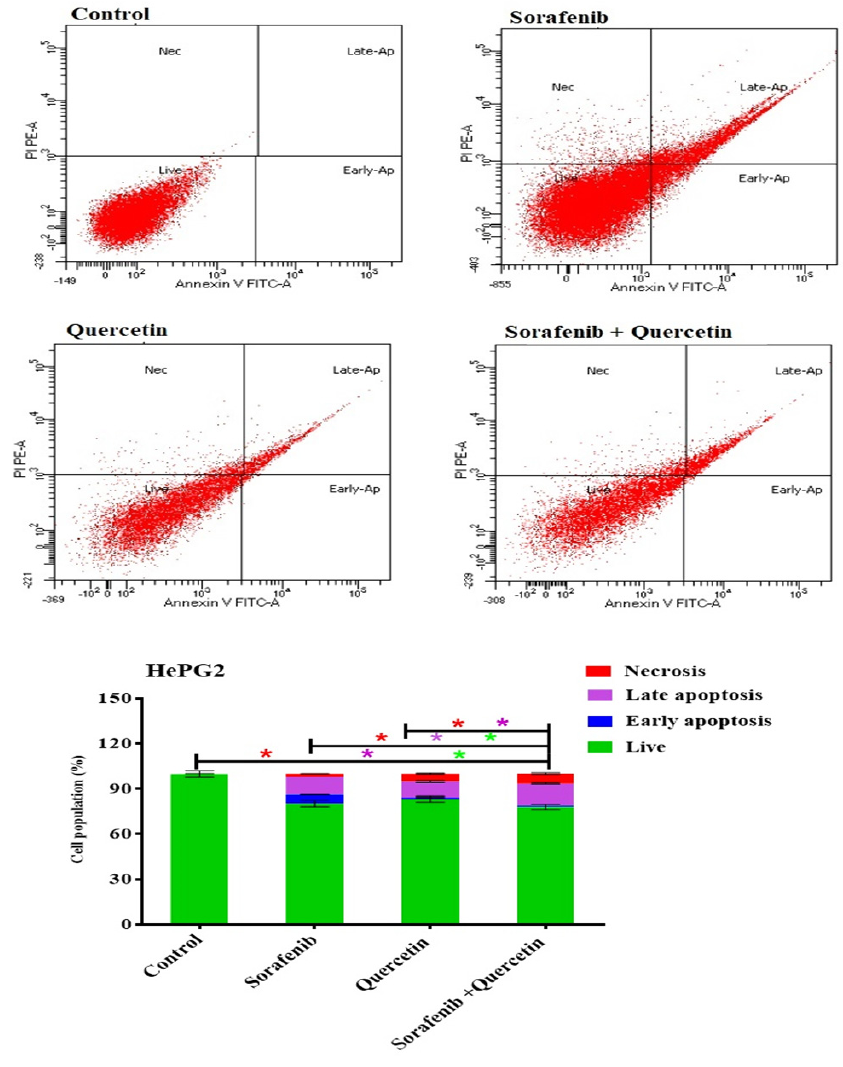
Figure 11. DNA cytometry analysis of Annexin–V-FITC showing representative flow cytometry panels of apoptosis, necrosis and cell vitality of HePG2 in response to 48 h exposure to media only (control) or (sorafenib, quercetin and sorafenib/quercetin, respectively). Cell populations (%), including early apoptosis, late apoptosis, necrosis and total cell death for the different treatments were shown in the lower panel. All data are presented as mean ± SEM for three replicates ( n = 3). Differences are considered significant at * p < 0.05.